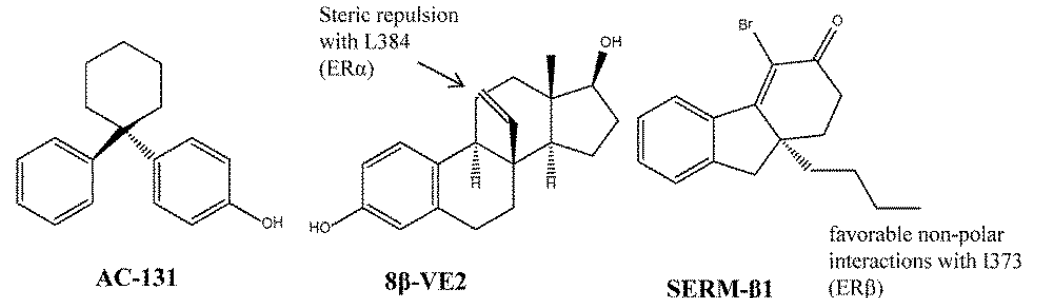
Figure 10. The non-steroidal AC-131 was used as the template in a SAR study to produce analogues such as compound 13 that showed ERβ selectivity. The feature that led to the ERβ selectivity for 8β-VE was repulsion from unfavorable interaction with M336 in ERβ, and for SERM-β1 was favorable hydrophobic contact with I373 in